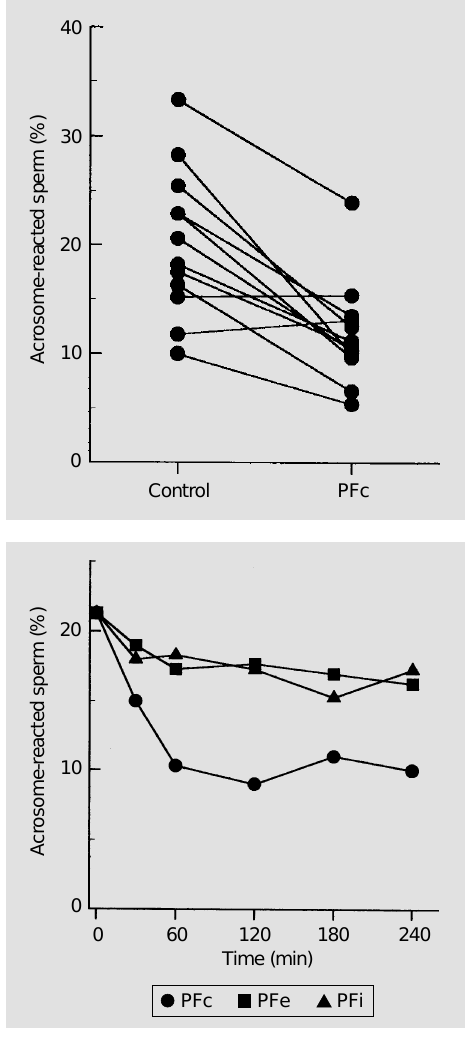
Figure 3 - Frequency of the NGP- induced acrosome reaction dur- ing incubation of sperm with PFc, PFe or PFi. Values for PFc were significantly different from controls at all time points after 30 min. In contrast, values for PFe and PFi were not different from controls at any time. Data are reported as the mean ± SEM of three replicate